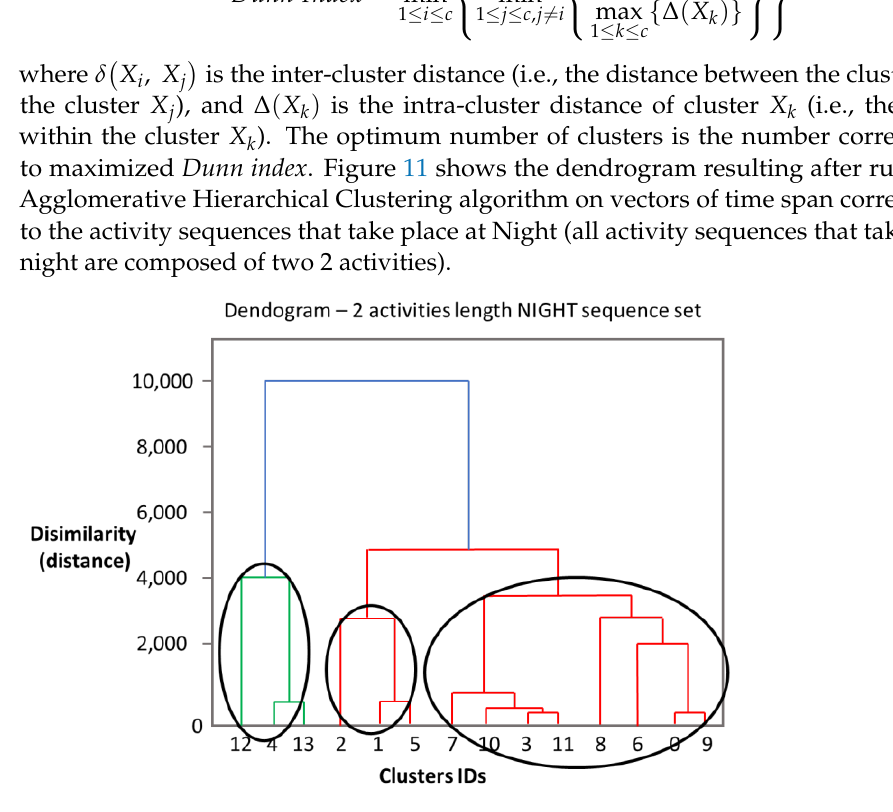
Figure 11. Dendrogram obtained when running the Agglomerative Clustering algorithm for Night sequences. On the X-axis the sequence ids are represented, and on the Y-axis the dissimilarity distance. Red, blue, and green colors are used to different clusters of activities created.